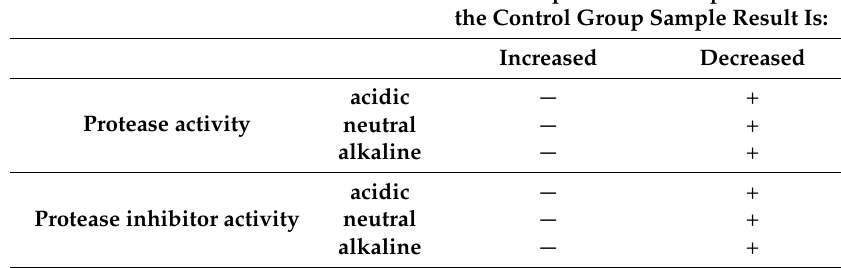
Table 4. Simplified interpretation of the proteolytic system activity results from the honey bee body surface elutions during contact with unfavorable or harmful